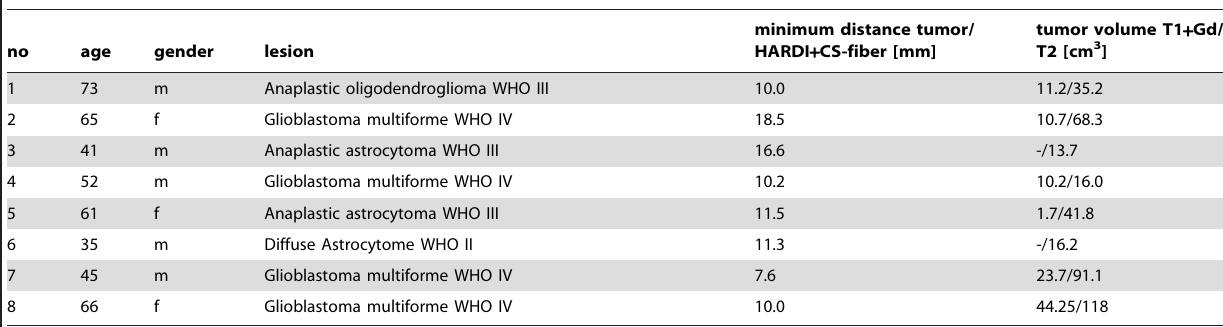
Table 1. Patient